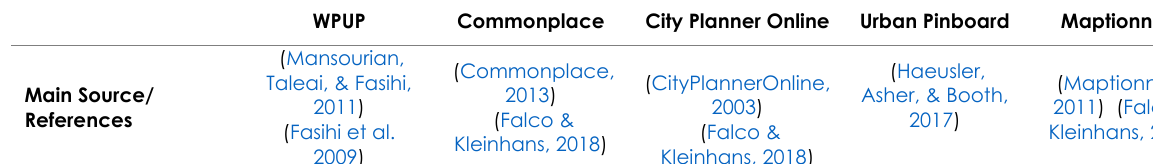
Table 5. Examination of Location Based Participatory